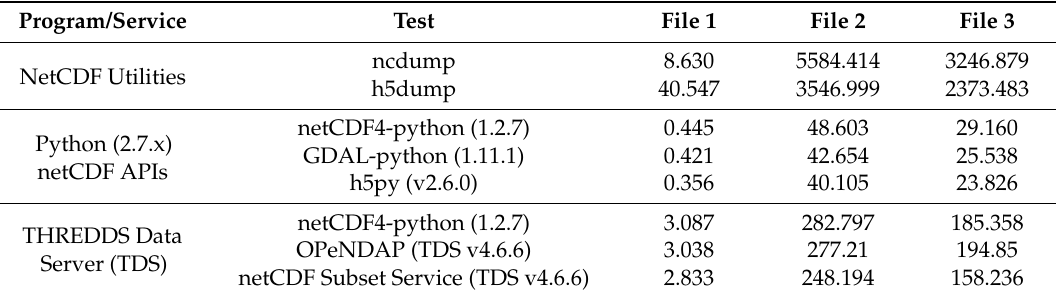
Table 4. Benchmark results (in